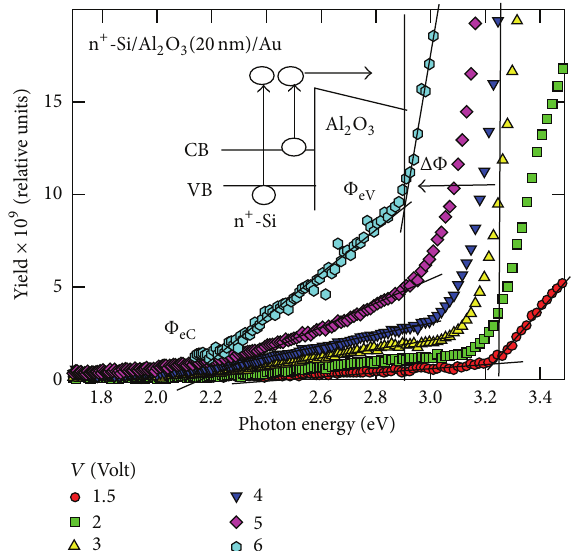
Figure 5: Linear plots of the photocurrent quantum yield in a n + -Si(100)/Al 2 O 3 (20nm)/Au capacitor measured under different positive voltages V applied to the metal electrode. Arrow ΔΦ 𝑒 indicates the observed field-induced spectral threshold shift. The inset schematically illustrates the observed electron IPE from theCB and VB of silicon corresponding to the spectral thresholds Φ Φ , respectively. eV